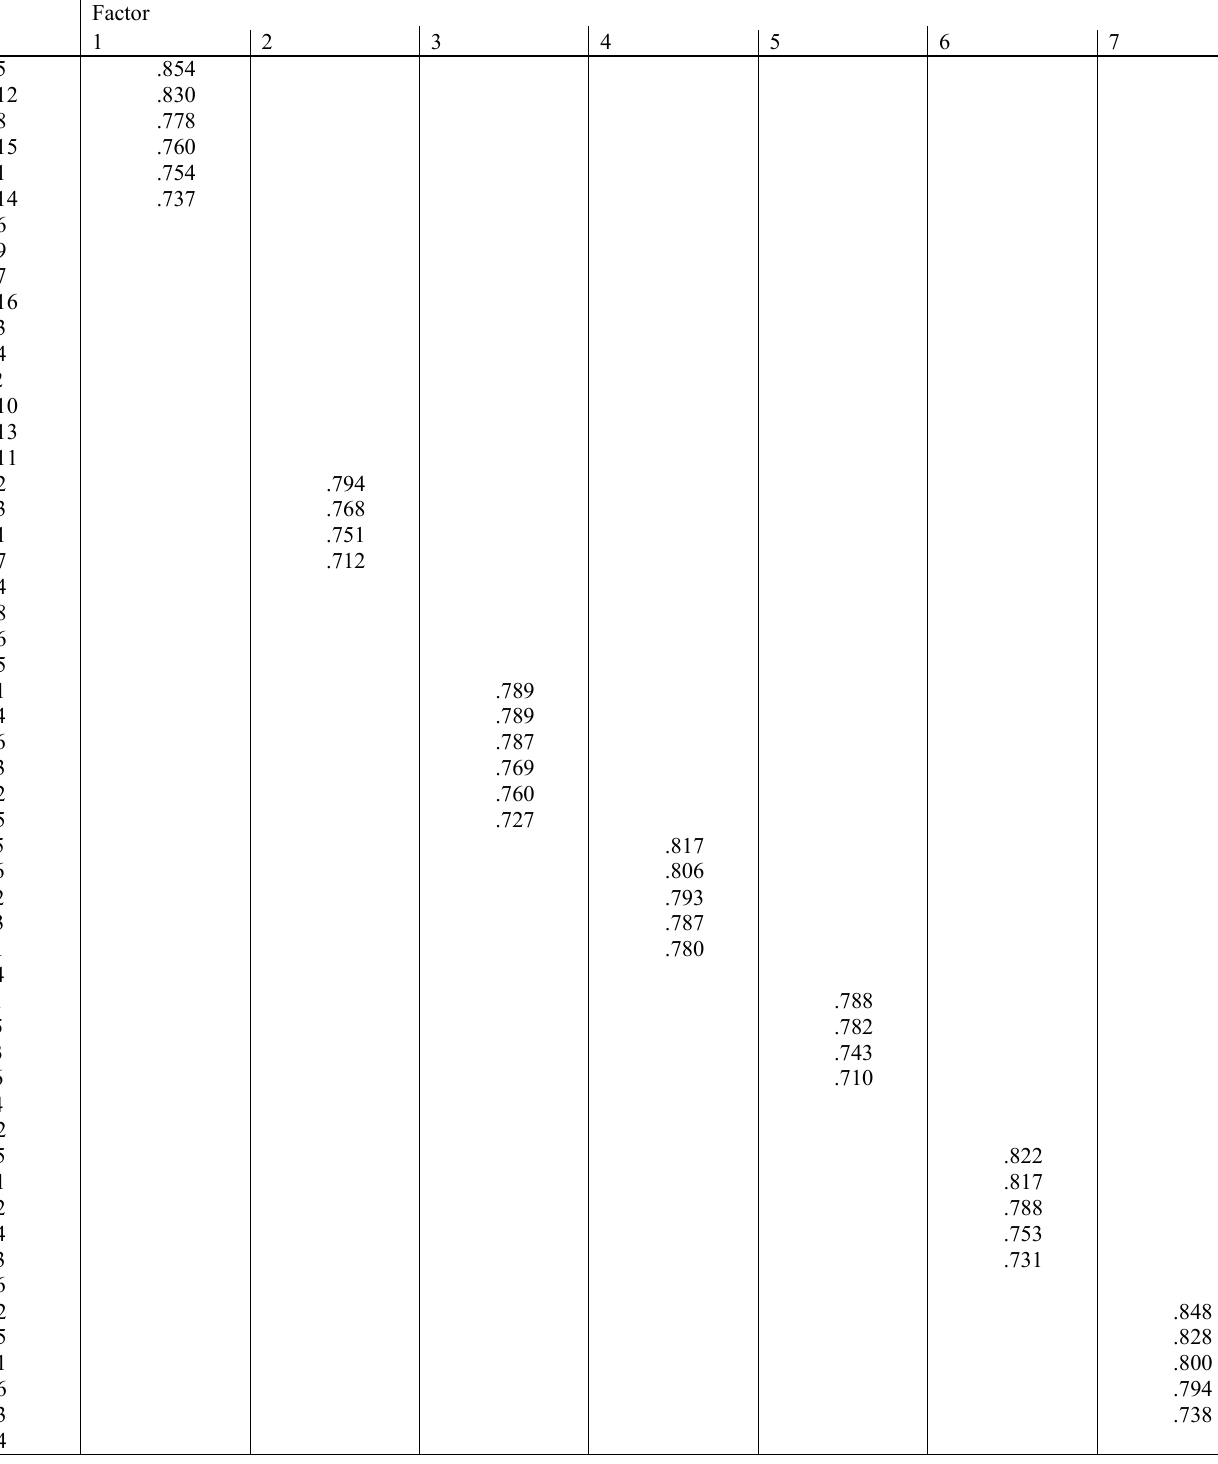
Table 5: Results of factor analysis for CSFs and Business